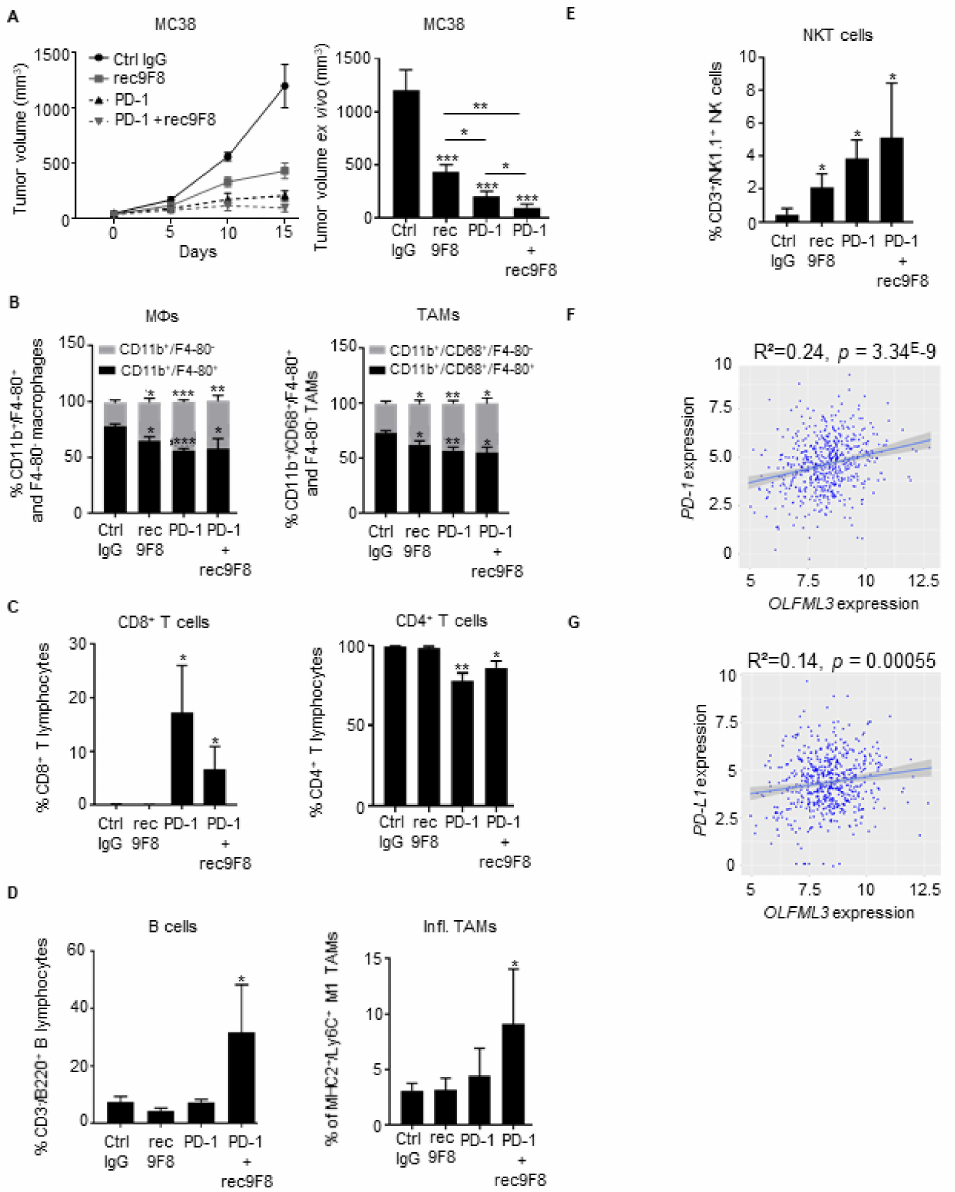
Figure 6. Anti-OLFML3 mAb treatment increases the antitumor effects of anti-PD-1 immunotherapy. ( A ) Growth curve (left) and ex vivo size of MC38 tumors isolated from mice treated with rec9F8 or PD-1 alone or a combination of rec9F8 and anti-PD-1 mAbs at the end of the experiment ( right ) ( n = 6–8 per group). Bars ( right ) represent the mean ± SEM; * p < 0.05; ** p < 0.01; *** p < 0.001. ( B ) Flow cytometry quantification of immature (CD11b + /F4-80 − ) and mature (CD11b + /F4-80 + ) macrophages ( left ) and immature (CD11b + /CD68 + /F4-80 − ) and mature (CD11b + /CD68 + /F4-80 + ) TAMs (right) in MC38 tumors isolated from mice treated with control IgG, anti-PD-1, rec9F8, or anti-PD-1 mAbs plus rec9F8. Bars ( right ) represent the mean ± SEM; * p < 0.05; ** p < 0.01; *** p < 0.001. ( C ) Flow cytometry quantification of intratumoral infiltration of ( left ) CD8 + T lymphocytes (CD45 + /CD3 + /CD8 + ) and ( right ) CD4 + T lymphocytes (CD45 + /CD3 + /CD4 + ). Bars represent the mean ± SEM; * p < 0.05; ** p < 0.01. ( D ) Flow cytometry quantification of intratumoral infiltration by ( left ) B lymphocytes (CD45 + /CD3 − /B220 + ) and ( right ) inflammatory macrophages isolated from mice bearing MC38 tumors treated with rec9F8 and anti-PD-1 mAbs, either alone or in combination as indicated. Bars represent the mean ± SEM; * p < 0.05. ( E ) Flow cytometry quantification of intratumoral infiltration by NKT cells (CD45 + /CD3 + /NK1.1 + ). Bars represent the mean ± SEM; * p < 0.05. ( F , G ) Scatter plots with linear regression lines comparing the mRNA levels of PD-1 ( F ) and PD-L1 ( G ) with that of OLFML3 in tumor samples from CRC patients. Differences were evaluated using Pearson’s correlation and Spearman’s rank correlation